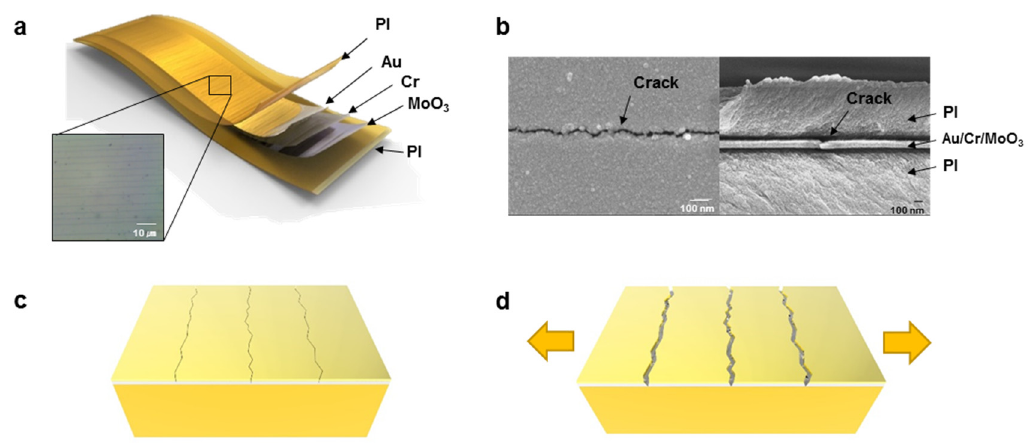
Figure 1. Schematic illustrations and scanning electron microscope (SEM) images of polyimide (PI) encapsulated crack sensor. ( a ) The schematic illustration and optical microscope image of the PI encapsulated crack sensor. ( b ) SEM image of the crack sensor before encapsulation (left), and cross-sectional SEM image after encapsulation (right). ( c ) The schematic illustration of generated cracks on metal layer before stretching. ( d ) The schematic illustration of widened cracks after